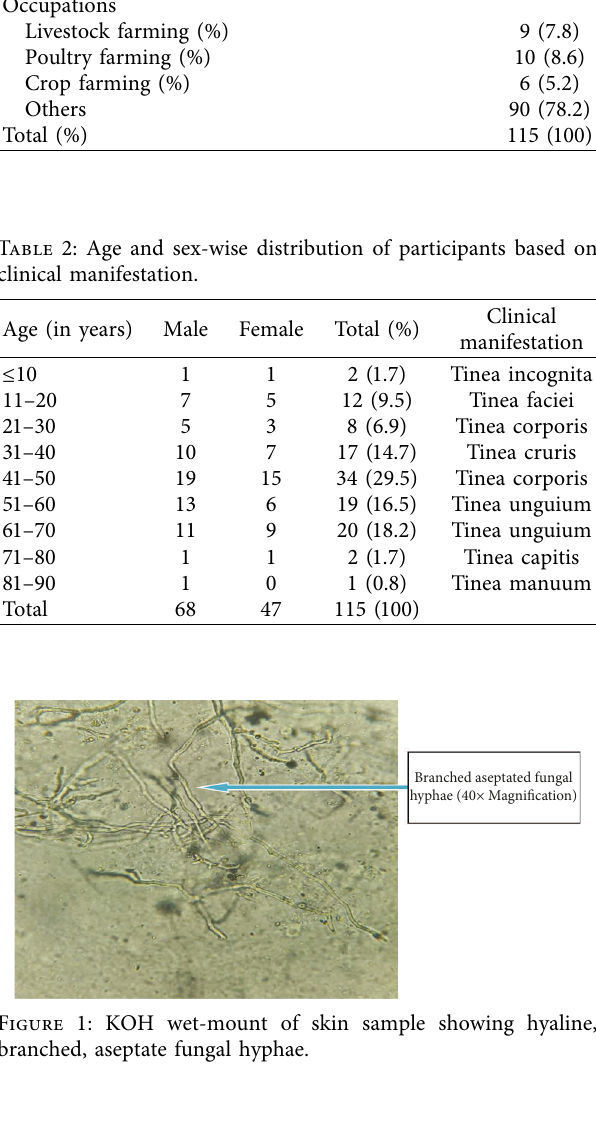
Budding Yeast cells with pseudohyphae (100× Magnification).